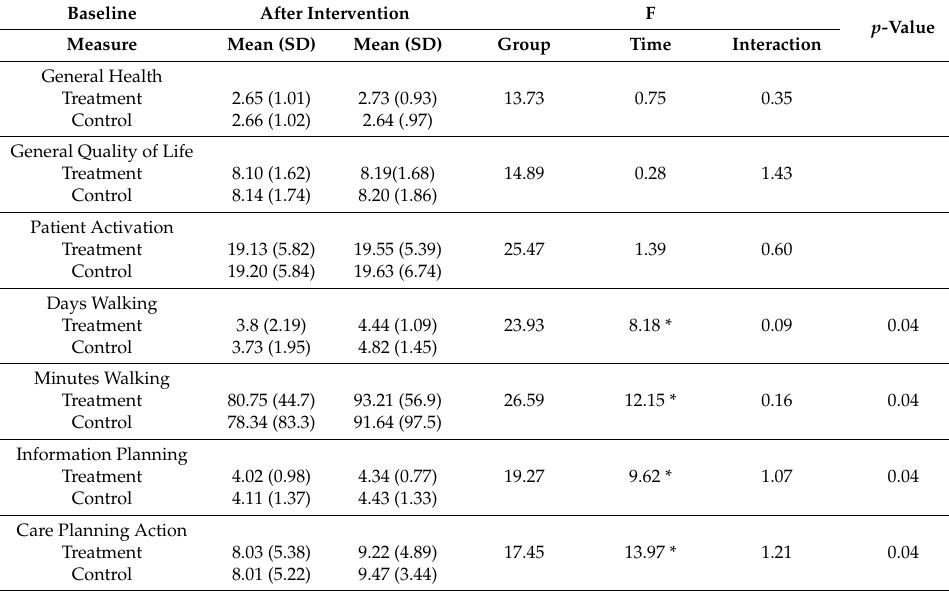
Table 3. Change in participants after